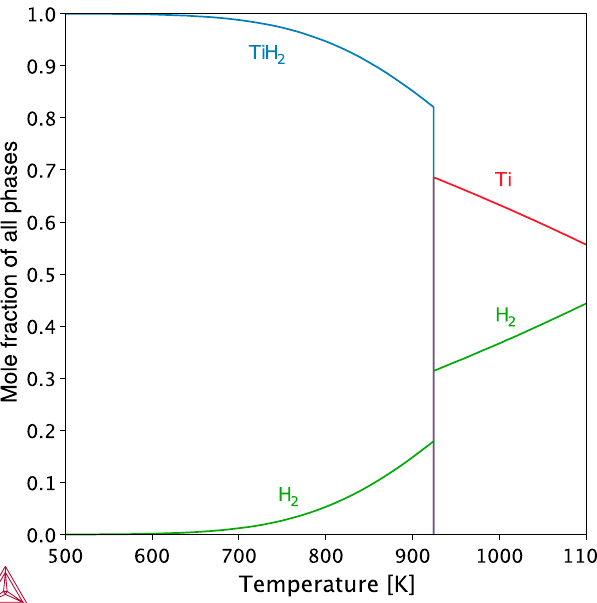
Figure 8. Simulation of phases in equilibrium in the system 1/3 mol of Ti and 2/3 mol of H as a function of temperature. Above 924 K, TiH2 becomes unstable and dissociates into H2 and Ti with some hydrogen in solid solution.